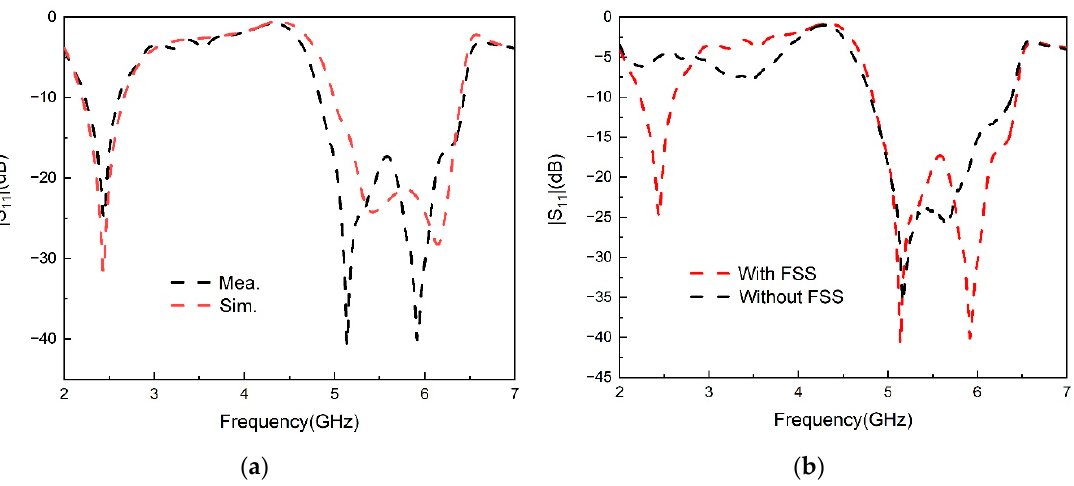
Figure 12. ( a ) The simulated and measured |S 11 | of the antenna and ( b ) the comparison of the measured |S 11 | of the antenna with and without the FSS.